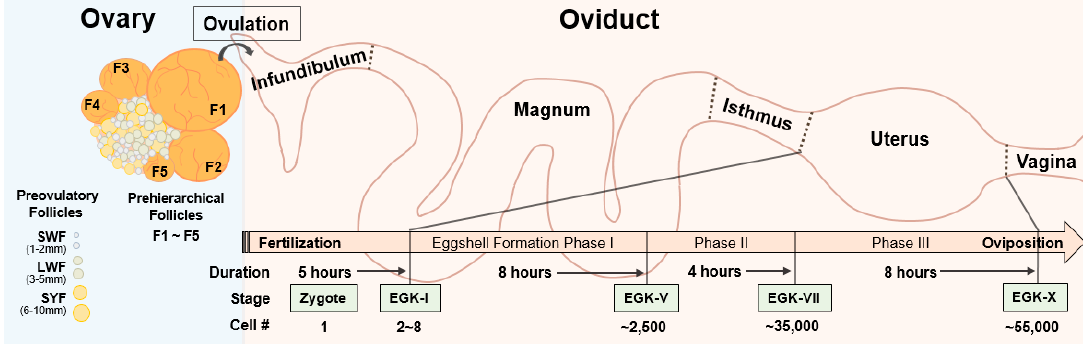
Figure 1. Overview of the reproductive system and embryonic development in chicken. Avian ovary contains large number of preovulatory follicles, small white follicles (SWF, 1–2 mm), large white follicles (LWF, 3–5 mm), and small yellow follicles (SYF, 6–10 mm), and approximately five prehierarchical follicles, naming F1 to F5, depending on their sizes. After ovulation, F1 follicles enters the avian oviduct and fertilizes in the infundibulum. After passing magnum and isthmus, a one-cell zygote starts first cleavage in the uterus and becomes an Eyal-Giladi and Kochav stage (EGK)-X blastoderm, having approximately 55,000 cells at the time of oviposition.